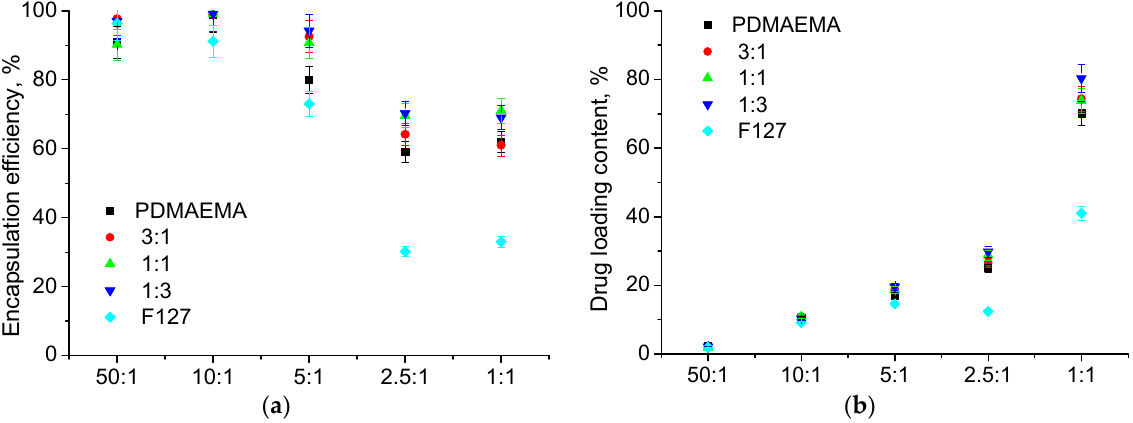
Figure 2. Variations of encapsulation efficiency ( a ) and drug-loading content ( b ) as a function of polymer-to-drug mass ratio of SCPMs and MPMs based on PDMAEMA-PCL-PDMAEMA and Pluronic F127 triblock copolymers. EE and DLC were determined spectrophotometrically, and each point represents the arithmetic mean ± SD of three separate measurements.